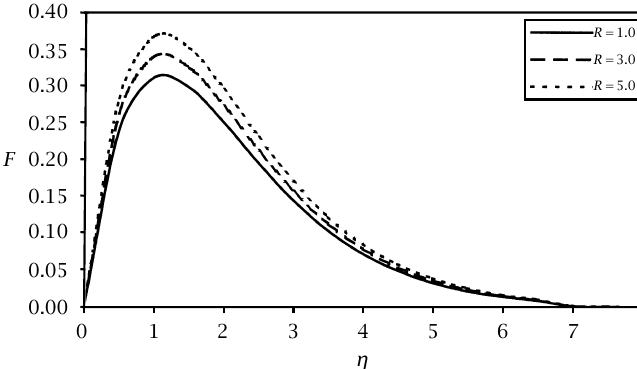
Figure 3.7 . The variation of F against η for m = 0 . 1 and M = 0 .